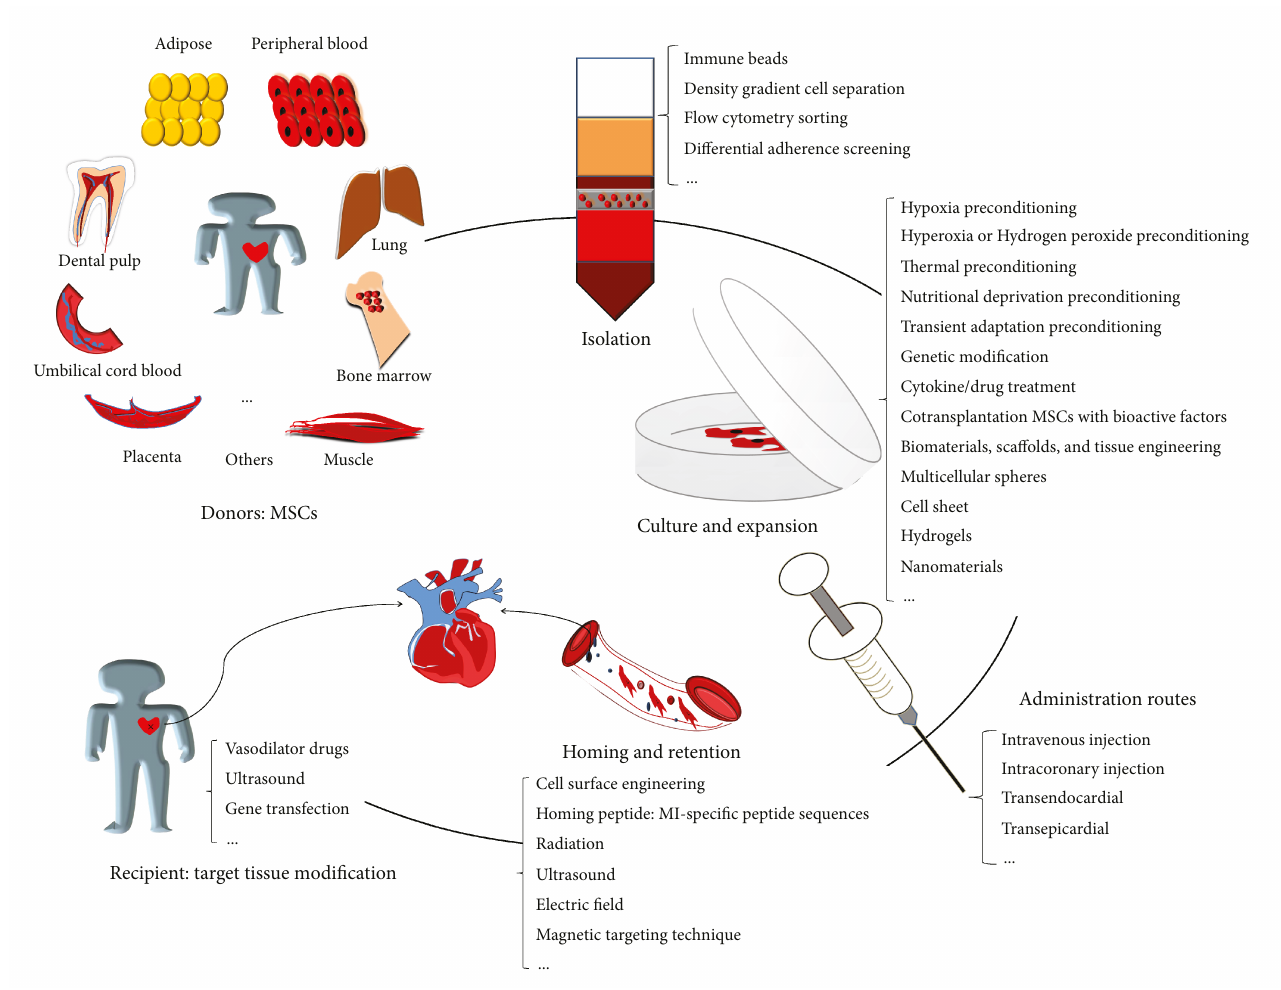
Figure 1: The procedures of MSC-based therapy, including donor selection, cell expansion, dosage, injection routes, homing, and target tissue modi fi cation. MSCs: mesenchymal stem